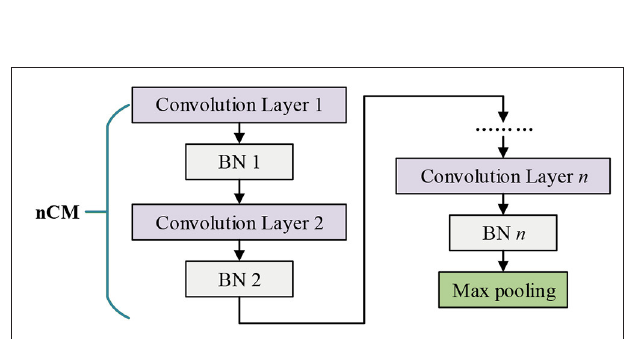
TABLE 1 | Abbreviation and full name.